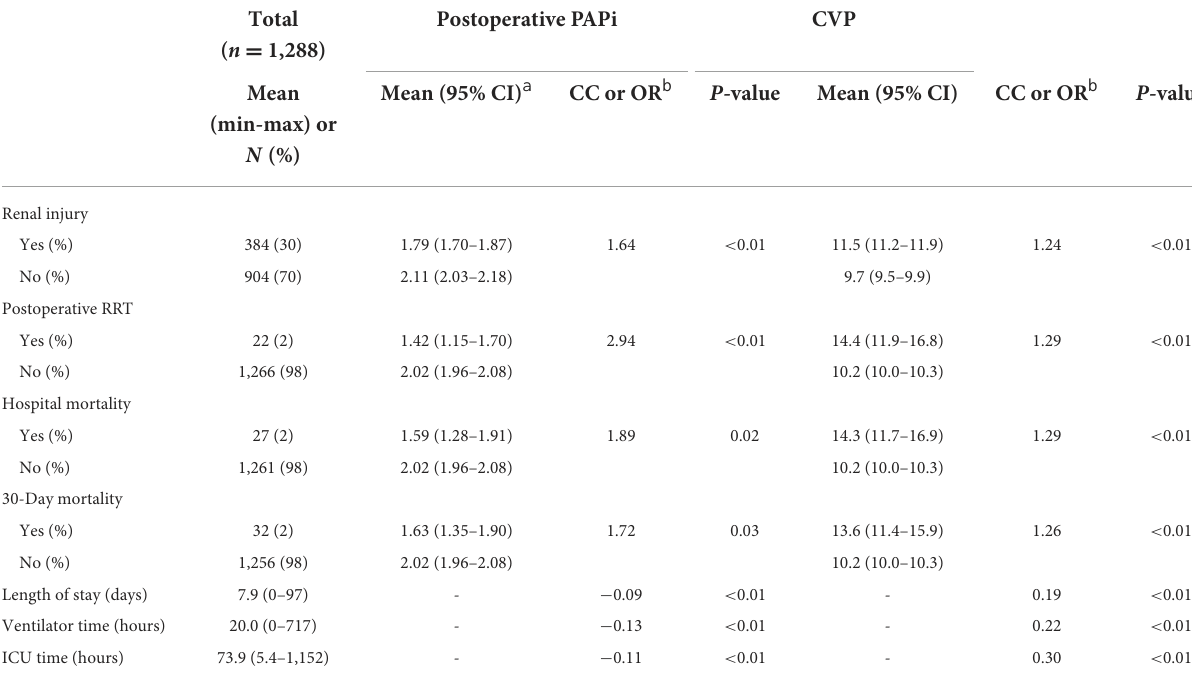
TABLE 2 Bivariate analysis of primary and secondary aims by CVP and